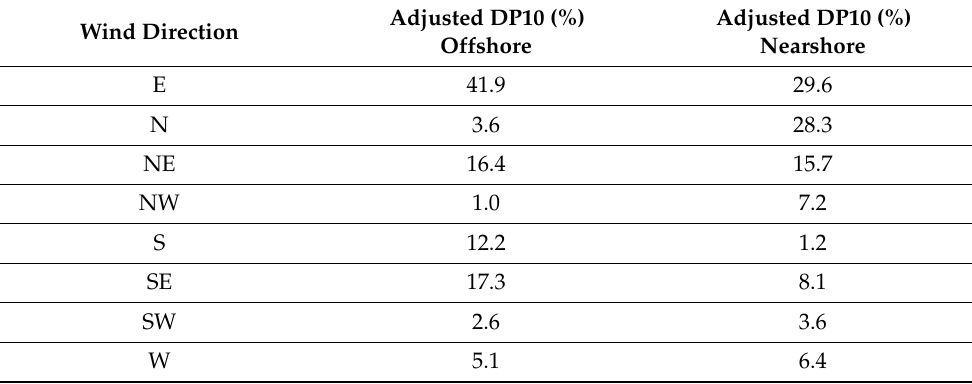
Figure 4. Percentage of adjusted bat activity in relation to wind direction (i.e., detection positive ten minutes (DP 10) of bat recordings for a given wind direction, divided by the frequency of occurrence (n) of the corresponding wind direction during the study periods) ( A ) for the nearshore location (Scheur-Wielingen) and ( C ) for the offshore survey locations (Norther, C-Power, and Northwester II). Percentage of wind direction occurrence during the 2017 and 2020 surveys at ( B ) the nearshore location and ( D ) the offshore locations. Table 3. DP10 per wind direction divided by the occurrence (n) of the corresponding wind direction (i.e., adjusted DP10) presented as percentages for the offshore and nearshore survey